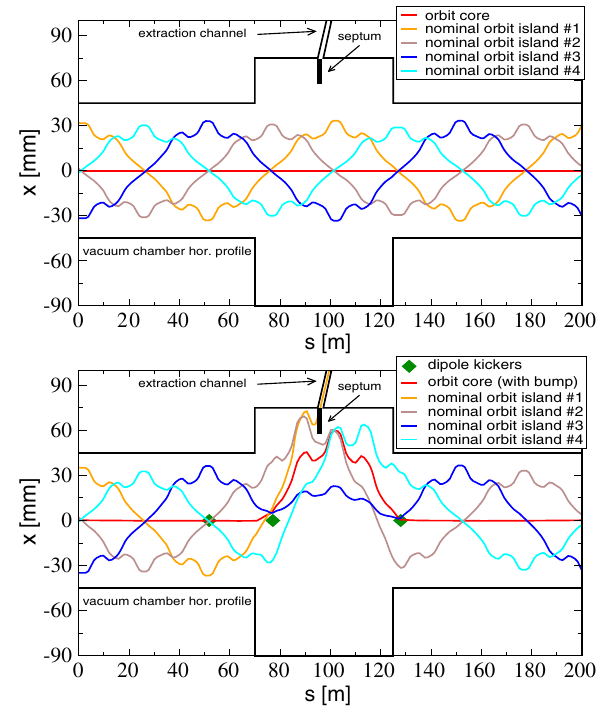
FIG. 3. Standard, with septum, MTE at the CERN PS. Top plot: the closed orbits for the four fixed points (islands) and the nominal central ring orbit (core) prior extraction. Bottom plot: the same orbits during the fast orbit bump created by three dipole kickers: To be extracted, the beam trapped in the first island needs a deflection from the magnetic septum. Only a fraction of the PS circumference ( 200 π m long) is